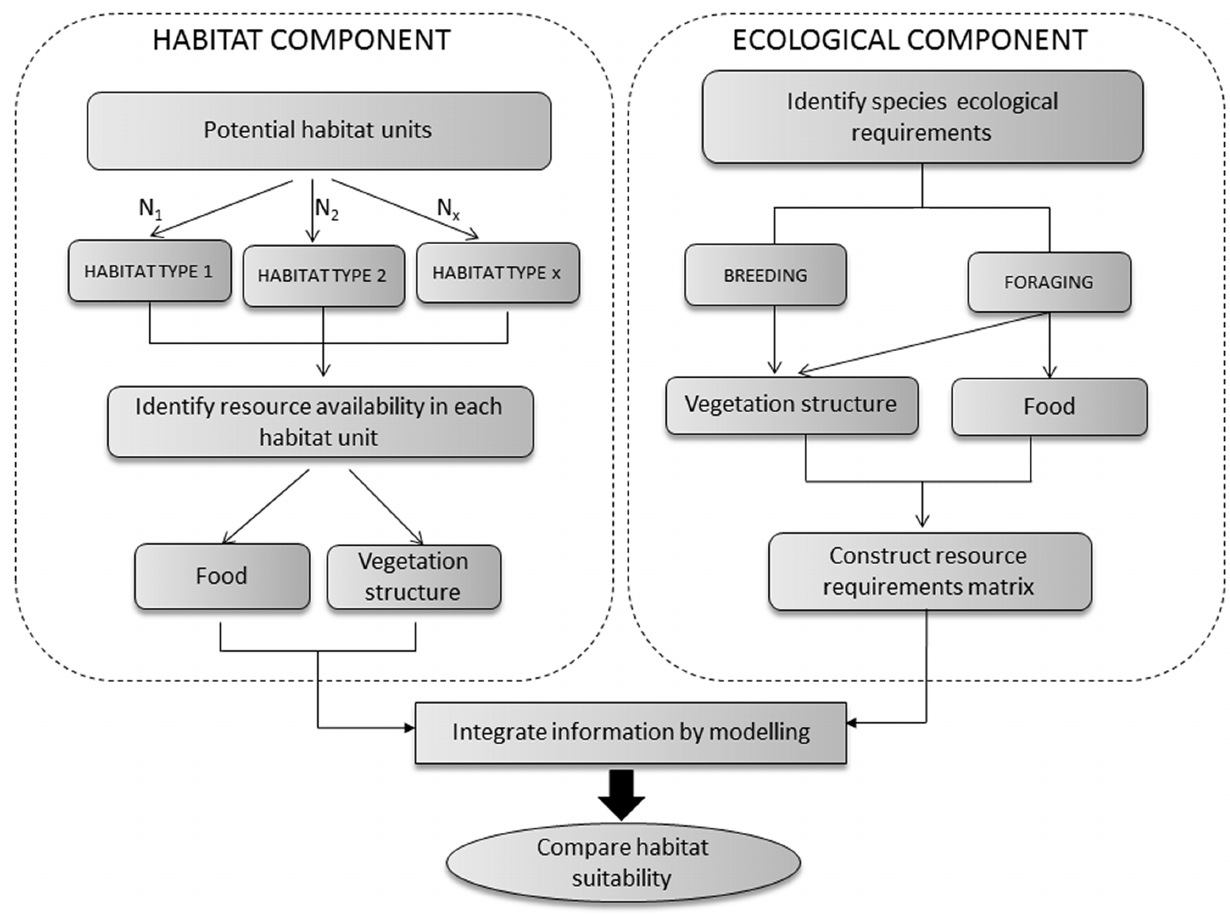
Figure 2. Overview of the framework followed to model the effect of different habitat types on habitat suitability for steppe bird species that was applied in this study.